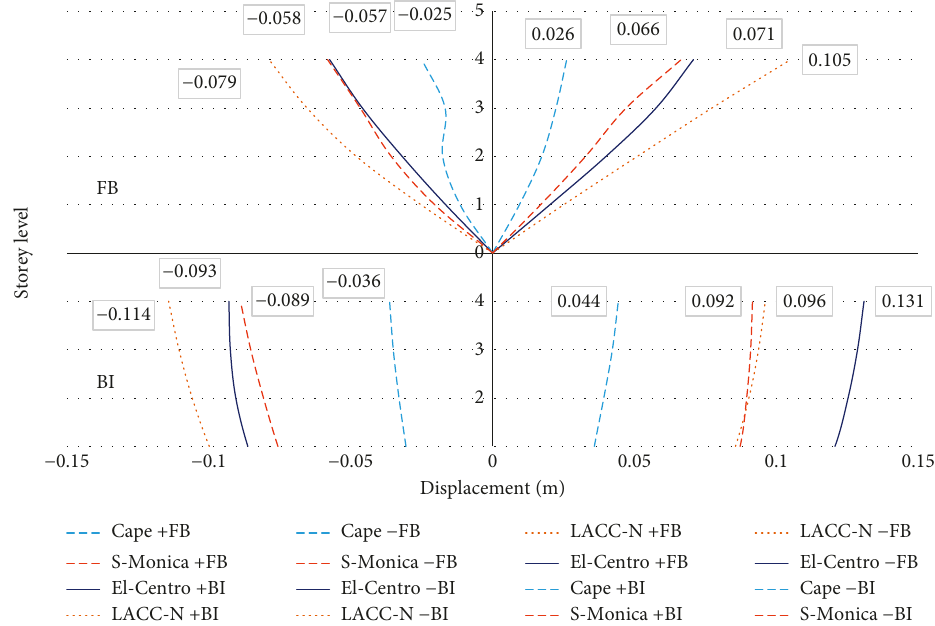
Figure 8: Envelope displacements of the shorter buildings in different floors under seismic loads. Table 4: Relative displacement of the shorter FFB and FBI buildings under considered motions.